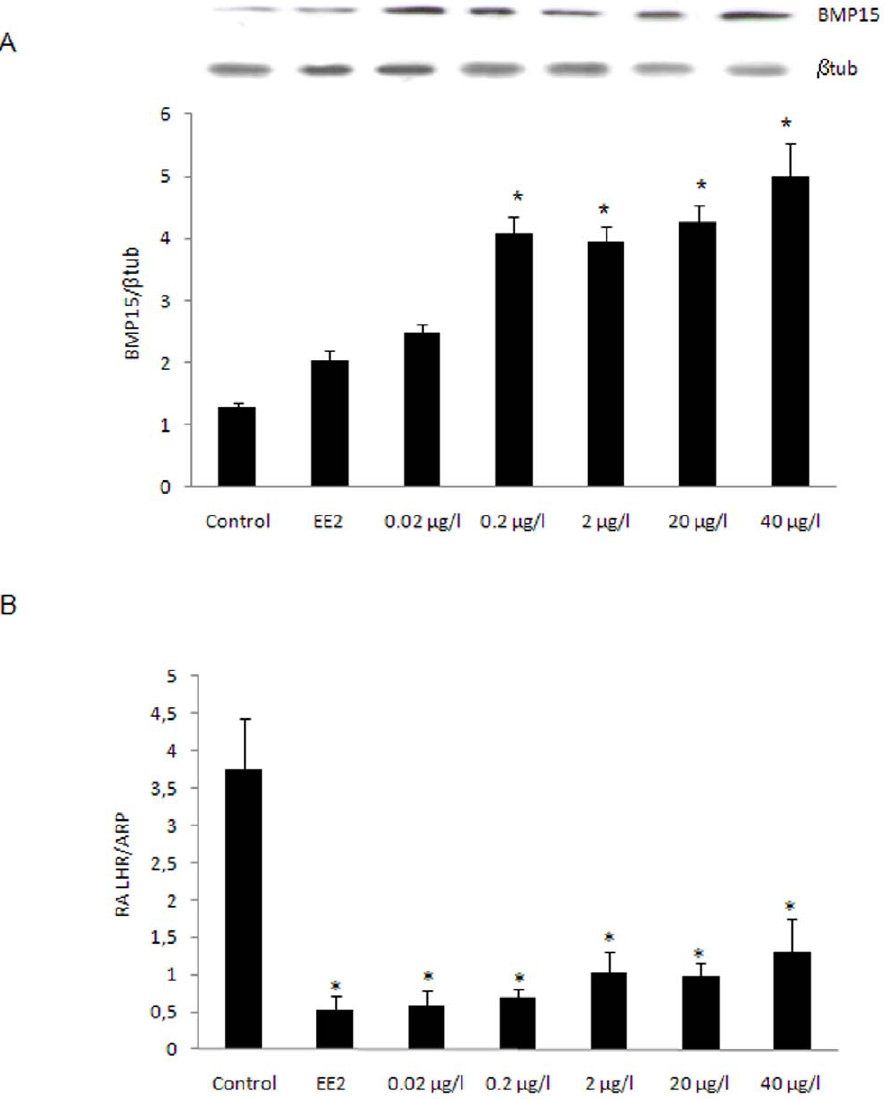
Figure 3. Up-regulation of ovarian BMP15 protein level and down-regulation of LHR gene expression in female zebrafish exposed to DEHP. A, BMP15 protein levels in vehicle control (EtOH), DEHP (0.02, 0.2, 2, 20 and 40 m g/l) or EE2 (25 ng/l) treated fish. Insert shows a representative Western blot while the graph represents densitometric analysis of BMP15 normalized using b -tubulin. Data were expressed as the mean 6 SD from at least four separate experiments. Asterisks* denote exposure groups that are significantly different from the control group (p , 0.05). B, Down regulation of ovarianLHR gene expression normalizedusing ARP gene infemales exposed toDEHP(0.02,0.2,2,20and 40 m g/l) orEE2 (25 ng/l.) Datawereexpressed as mean 6 SD from at least four independent experiments. Asterisks* indicate statistical significant differences respect to control group (p , 0.05).